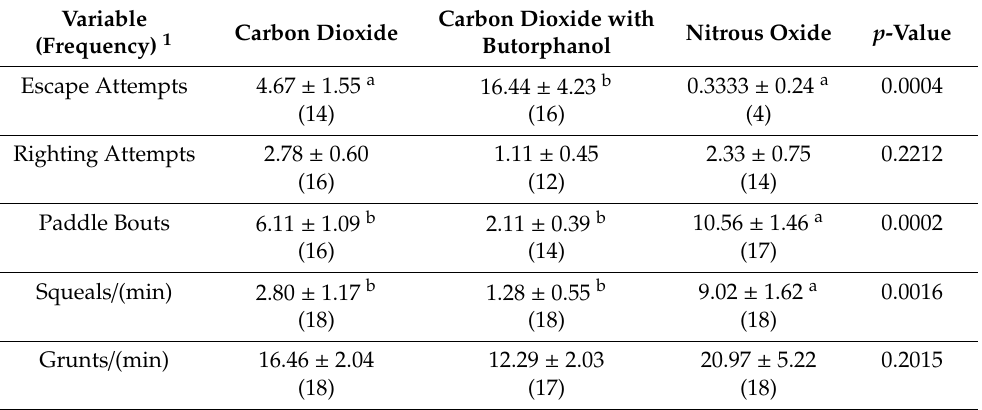
Table 4. Behavioral event results (mean ± SE) on individual pigs for the three treatments. The numbers in parentheses indicate how many animals out of 18 in each treatment performed that specific behavior listed under column 2,